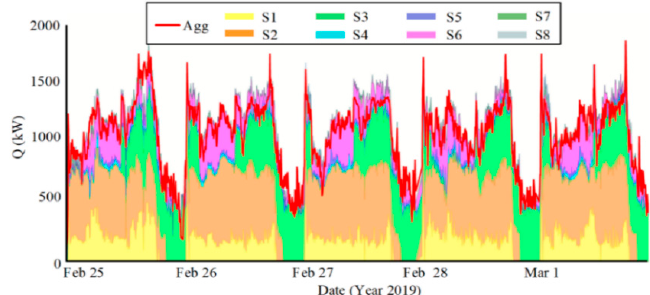
Figure 8. Estimation of the individual load contribution to the total aggregated signal.